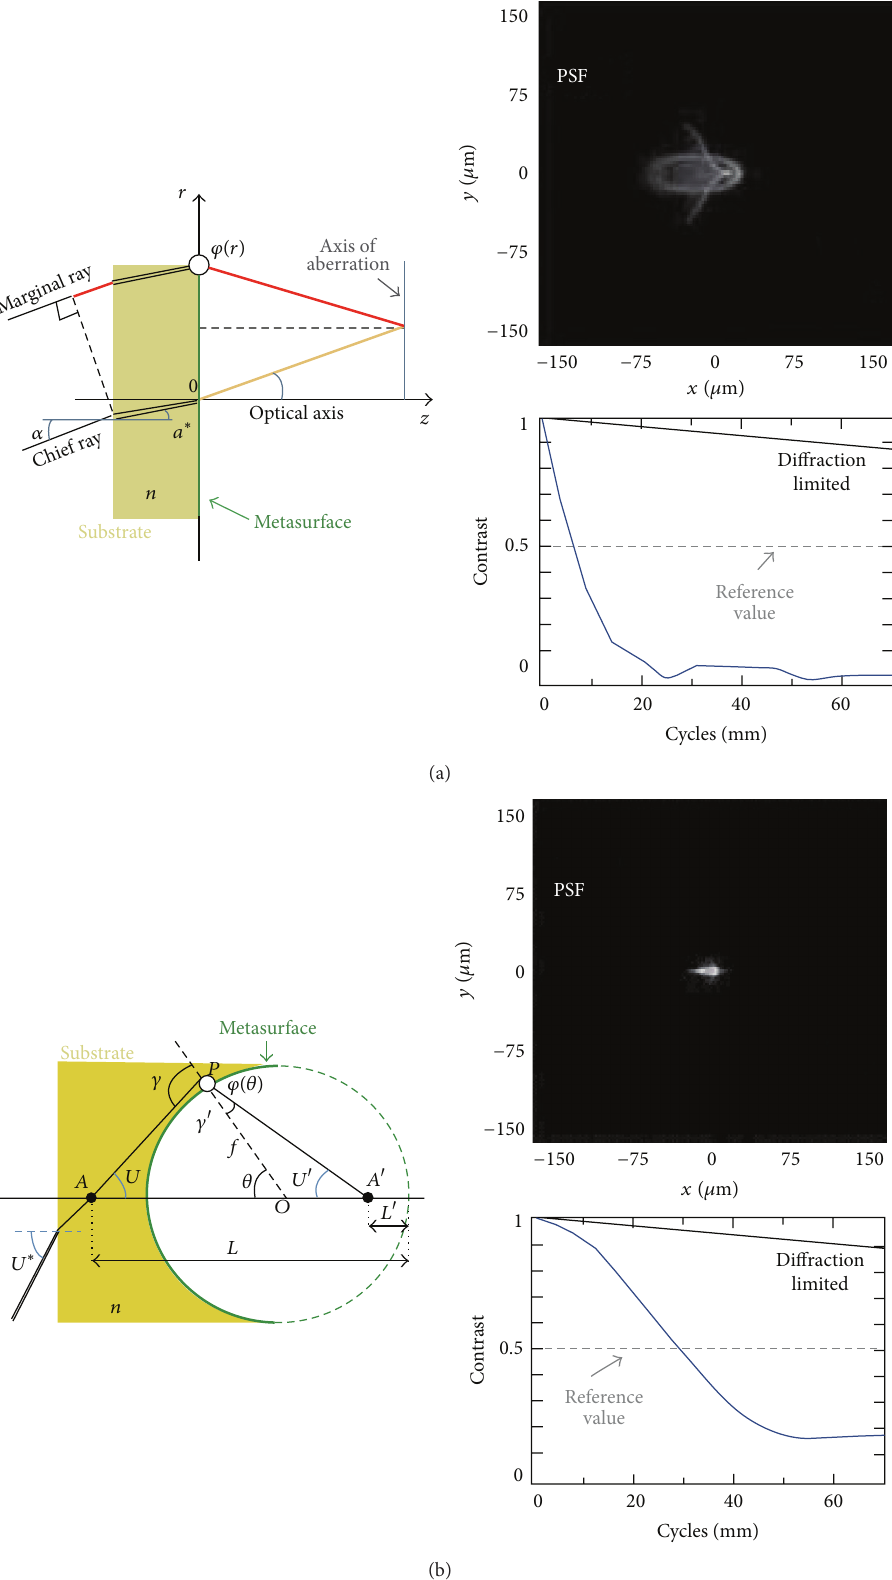
Figure 48: (a) Schematic, PSF, and MTF of a flat metasurface lens. (b) Schematic, PSF, and MTF of a conformal metasurface lens. Figures are reproduced from